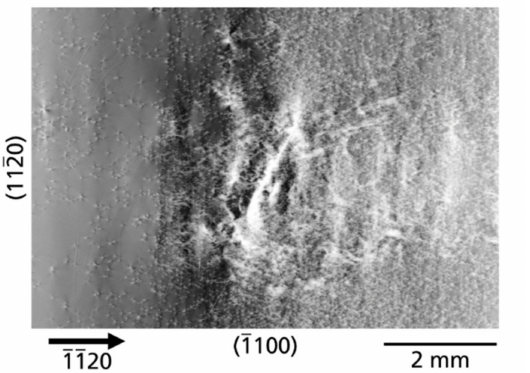
Figure 7. Area with high defect density initiated during growth by subsurface damage of the prepared wafer surface (1120